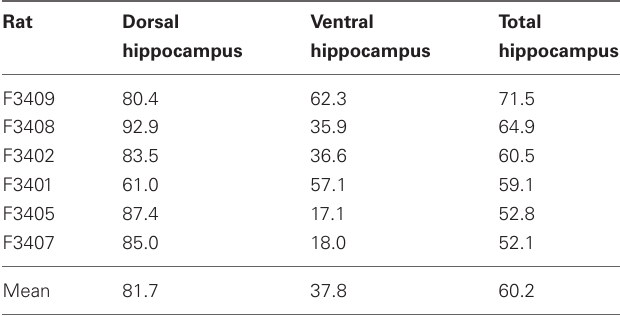
Table 2 | Percentage of damage to the cell layers of the dorsal hippocampus, the ventral hippocampus, and the entire